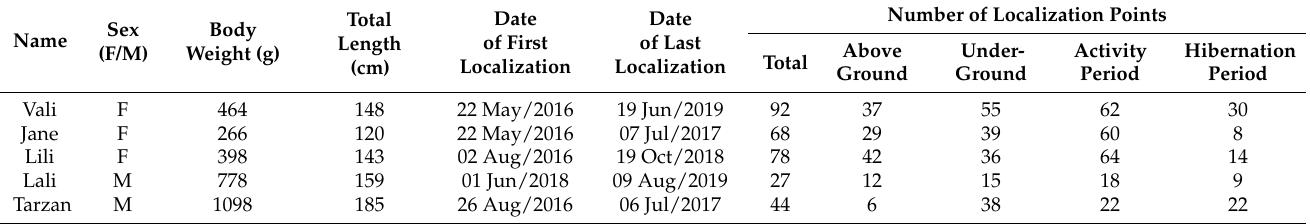
Table 1. Name, sex (F: female or M: male), body weight (g), total length (cm), length of the tracking period (first and last day), number and seasonal distribution of above-ground and underground locations of radio-tracked Caspian whipsnakes ( Dolichophis caspius